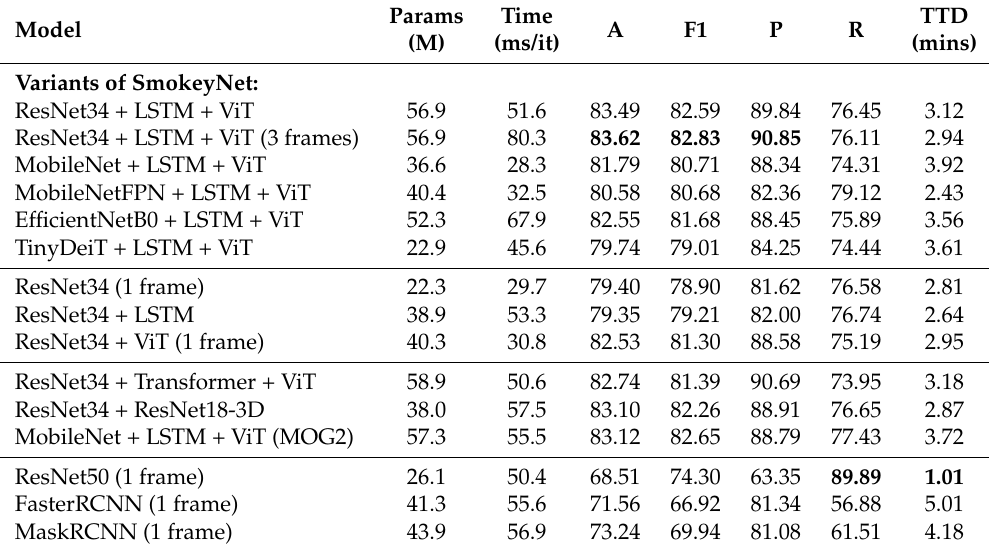
Table 2. Accuracy (A), F1, precision (P), recall (R), and average time-to-detection (TTD) evaluation metrics on the test set. Best results are bolded